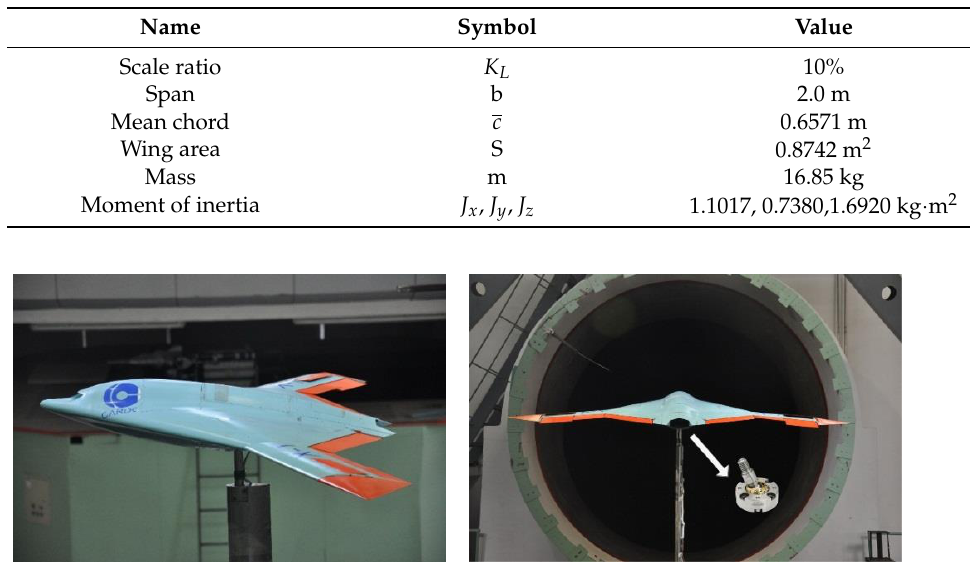
Table 1. Physical properties of the dynamically scaled aircraft model.